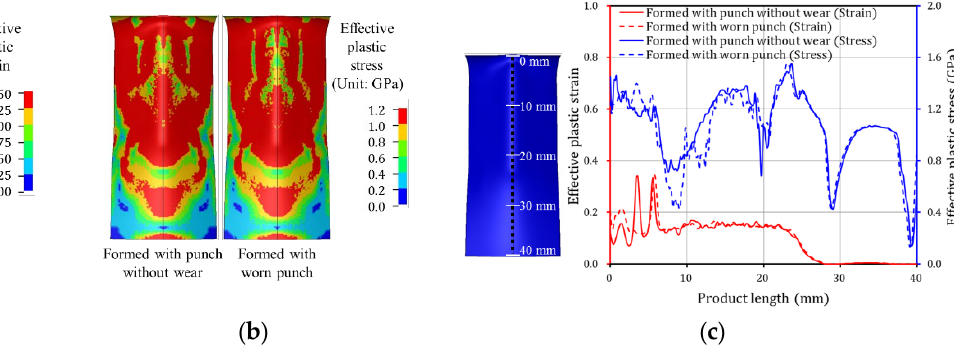
Figure 19. Effective plastic strain and stress of the product formed with punch geometry without wear and worn punch geometry: ( a ) contour plot of effective plastic strain, ( b ) contour plot of effective plastic stress, ( c ) quantitative comparison of effective plastic stress and strain.